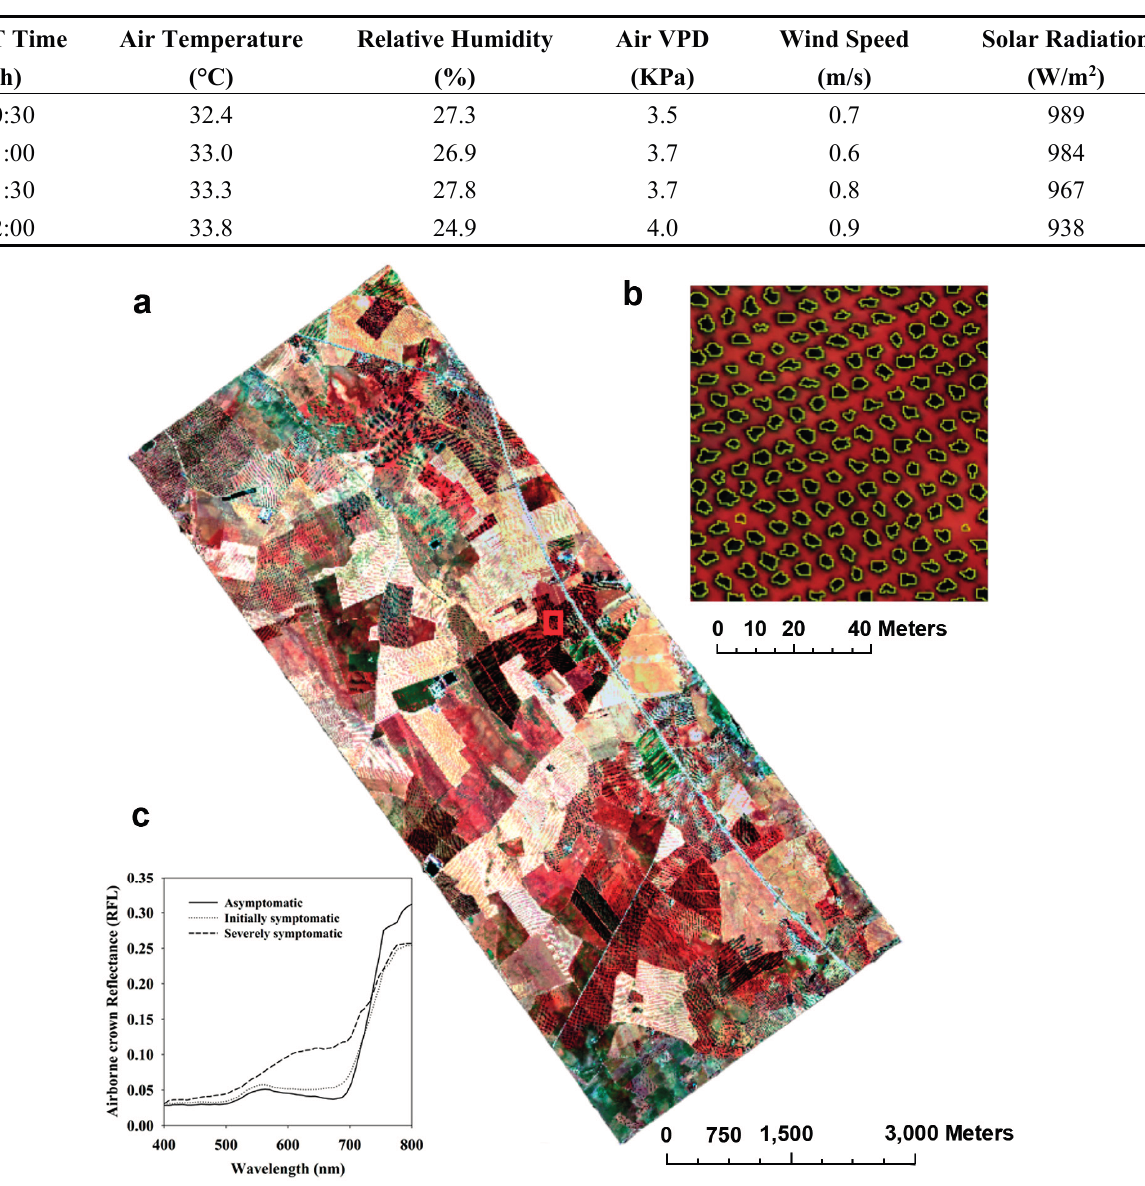
Table 3. Local atmospheric conditions measured by a portable weather station during the flight at 30-min interval.